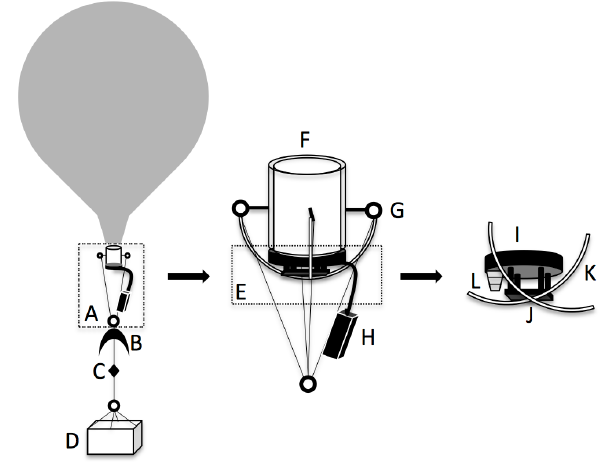
Figure 4. For the single balloon method of controlled descent the balloon flight train consists of (A) the automatic balloon valve and pressure sensor assemblies, (B) a parachute, (C) a 52m string un- winder and (D) the instrument payload. The valve and pressure sen- sor assemblies include (E) a valve cap assembly, (F) a PVC pipe segment, (G) four screw-in eyelets and (H) a pressure sensor, logic board and batteries. The pipe cap assembly includes (I) a pipe cap, (J) a hot wire string cutter, (K) two cap anchoring strings and (L) a helium fill